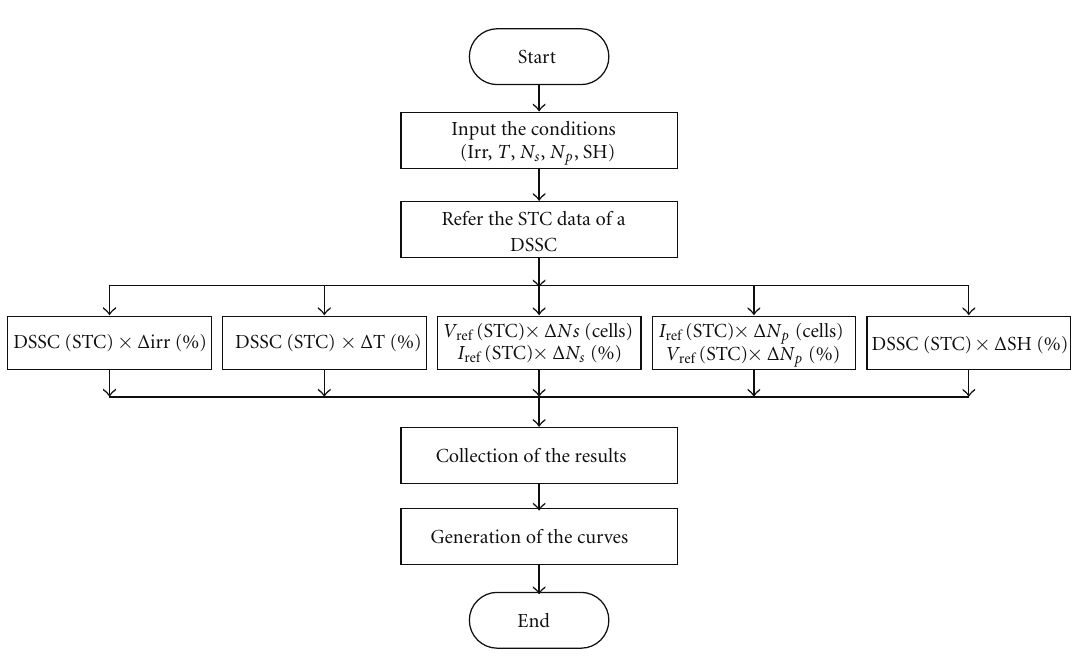
Figure 5: Proposed SS algorithm flow